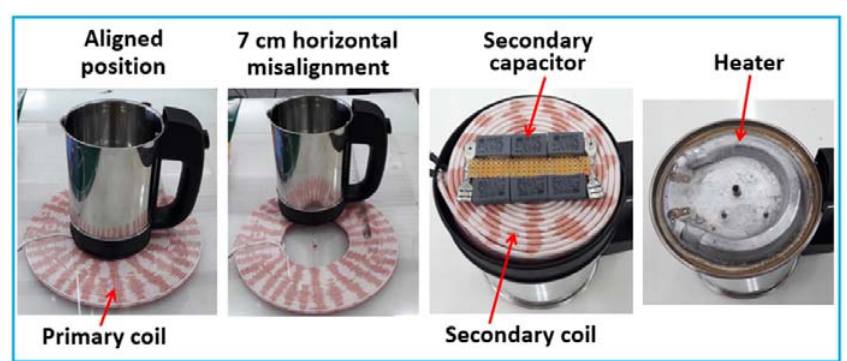
Figure 9. Free ‐ positioning kettle setup.